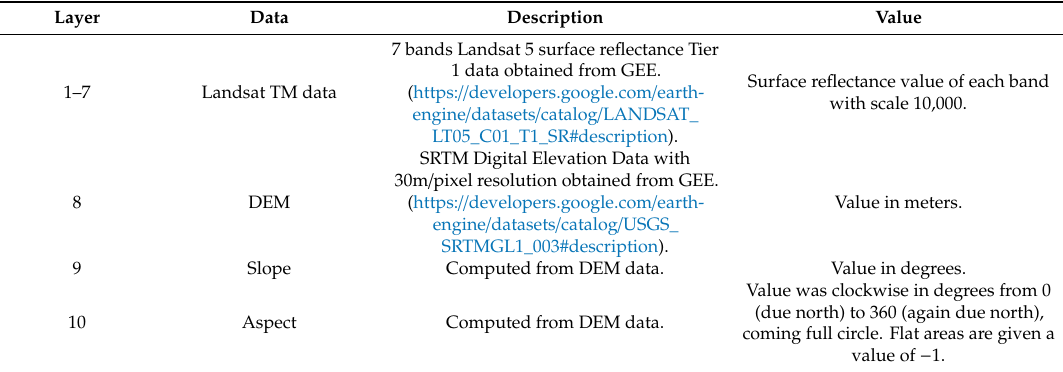
Table 3. The detail of the input layers for U-net like